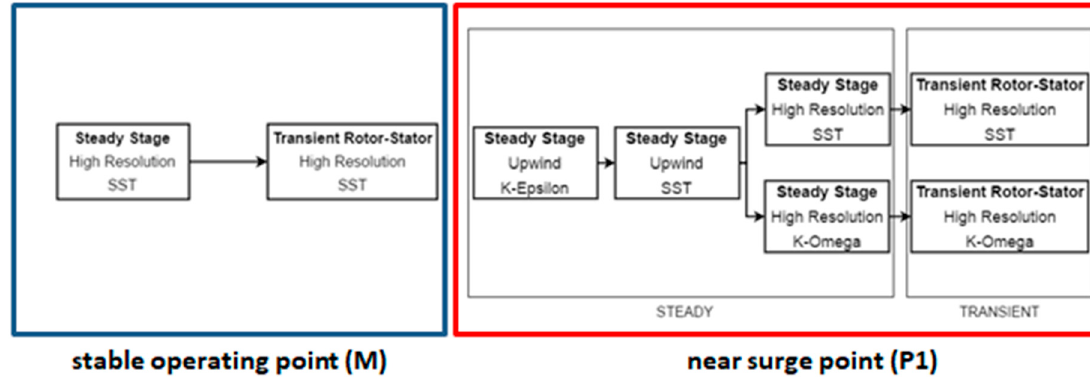
Figure 3. CFD simulation dataset for operating point M (close to design) and P1 (close to surge).